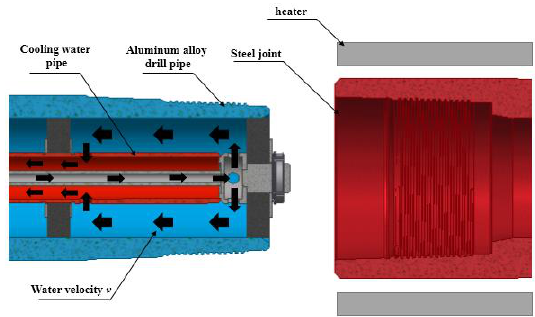
Figure 1. Status of hot assembly start.